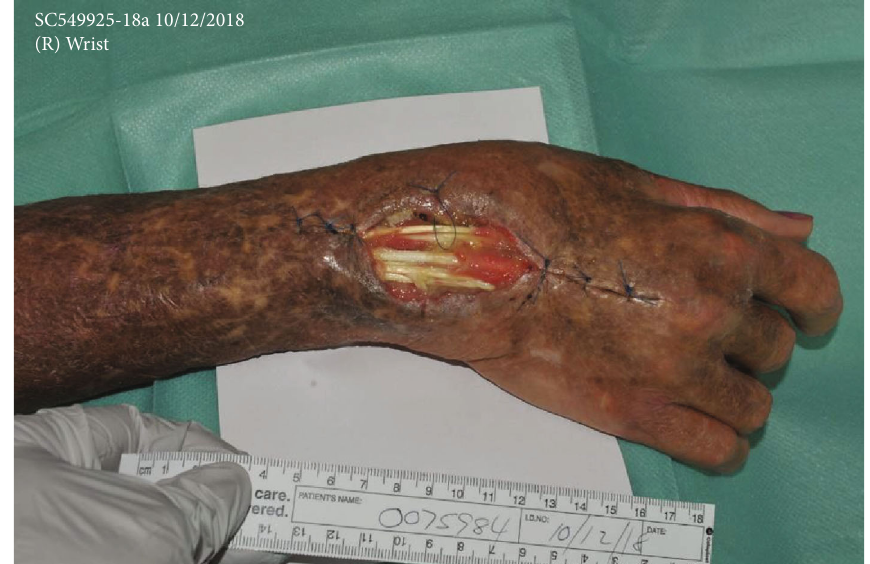
Figure 2: Clinical photograph of the right hand in between serial surgical debridement and washout. Note the extensive soft tissue damage with exposed extensor